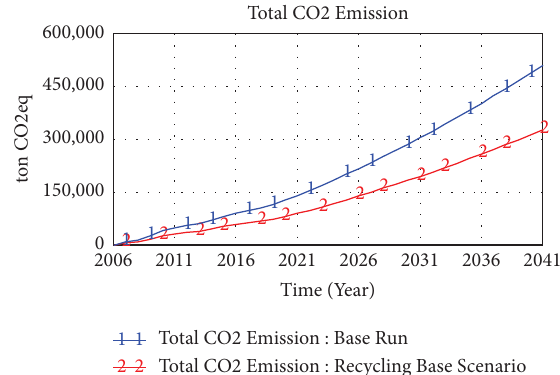
Figure 9: Comparison of the variable trend of the accumulated CO 2 emission for both options.